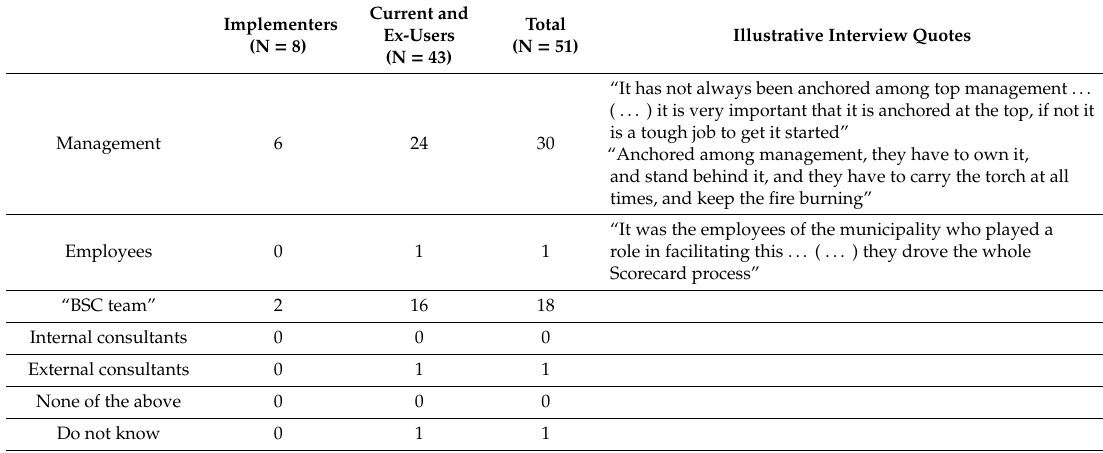
Table 7. Involvement in the implementation